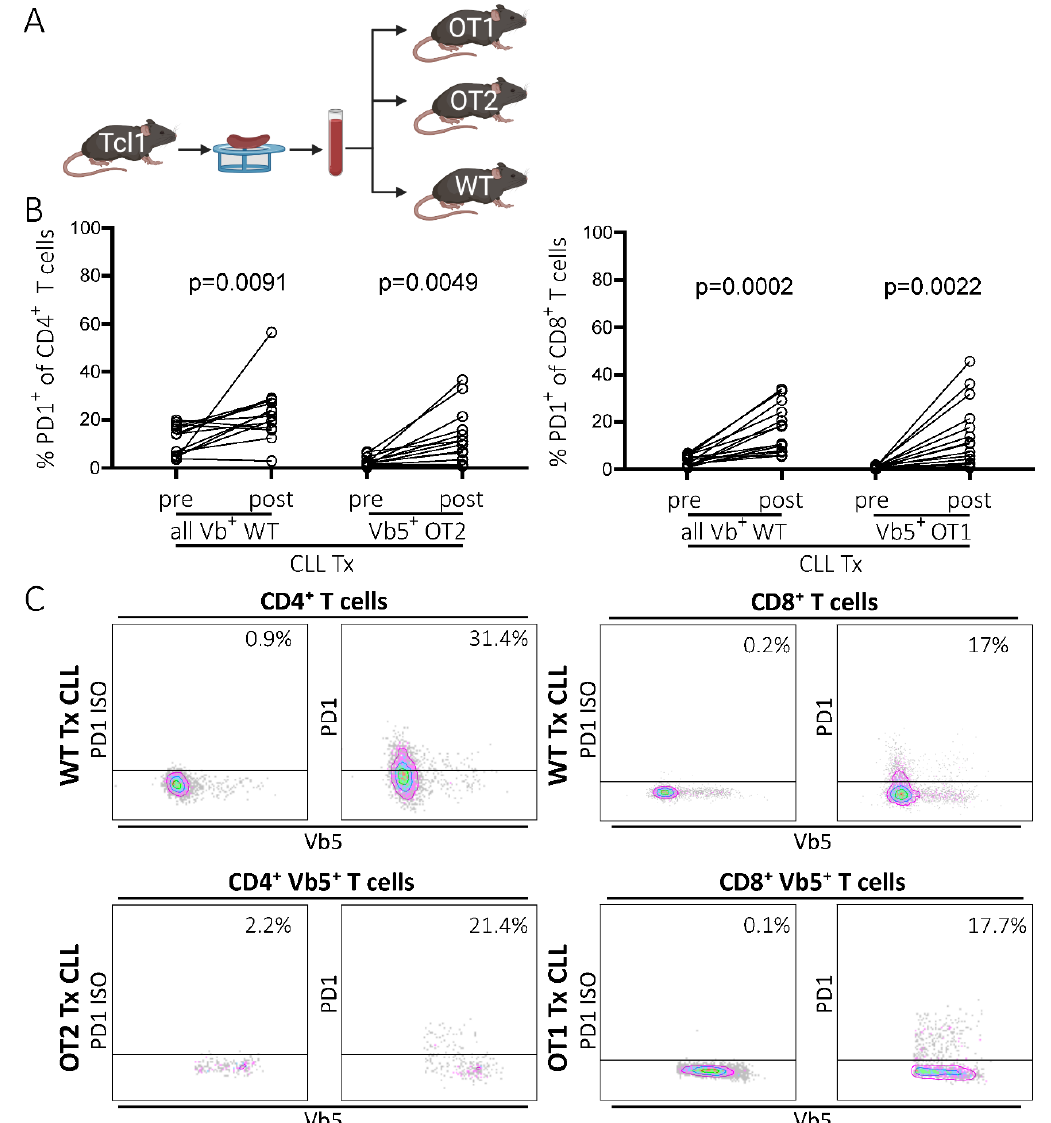
Figure 1. PD1 expression of T cells in WT and OT1/OT2 mice in peripheral blood, before and after CLL tumor transplantation. ( A ) Transplantation scheme. CLL tumors were derived from the Tcl1 mouse model. Splenocytes containing CLL cells were transferred intraperitoneally into congenic recipient mice (created with BioRender.com, 11 June 2021). ( B ) Percentage of PD1 positivity in the CD8/CD4 T cell compartments of WT mice (all Vbpos) and of transgenic Vb5pos CD8 (OT1 mice) and Vb5pos CD4 (OT2 mice) T cells in peripheral blood before and post-transplantation (last measurement before sacrifice day) analyzed by flow cytometry. ( C ) Representative flow cytometry data showing PD1pos T cell fractions in peripheral blood samples of WT and OT1/OT2 mice post-transplantation. Left panel shows PD1 isotype control, right panel shows actual PD1